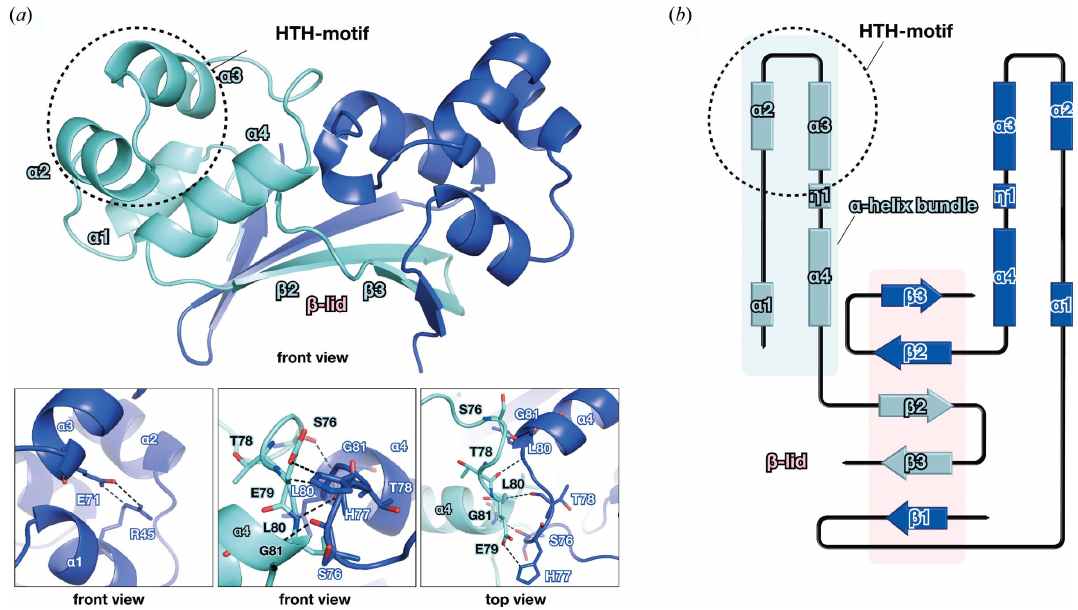
Figure 1 Crystal structure of Mt HigA3. ( a ) Front view of the overall Mt HigA3 structure. Two monomers of Mt HigA3 interact to form a dimer with HTH motifs on either side of the dimer structure, and a (cid:2) -lid is formed as a result of this dimer organization. Front view of the salt bridge formed between Arg45 and Glu71 (left). Front view (middle) and top view (right) of the hydrophilic interactions between the loop and the adjacent (cid:3) 4-helix are enlarged in the panels. Each monomer, including residues from each chain, is coloured cyan and blue. ( b ) Topology diagram of the Mt HigA3 dimer. The secondary structure elements are coloured the same as in ( a